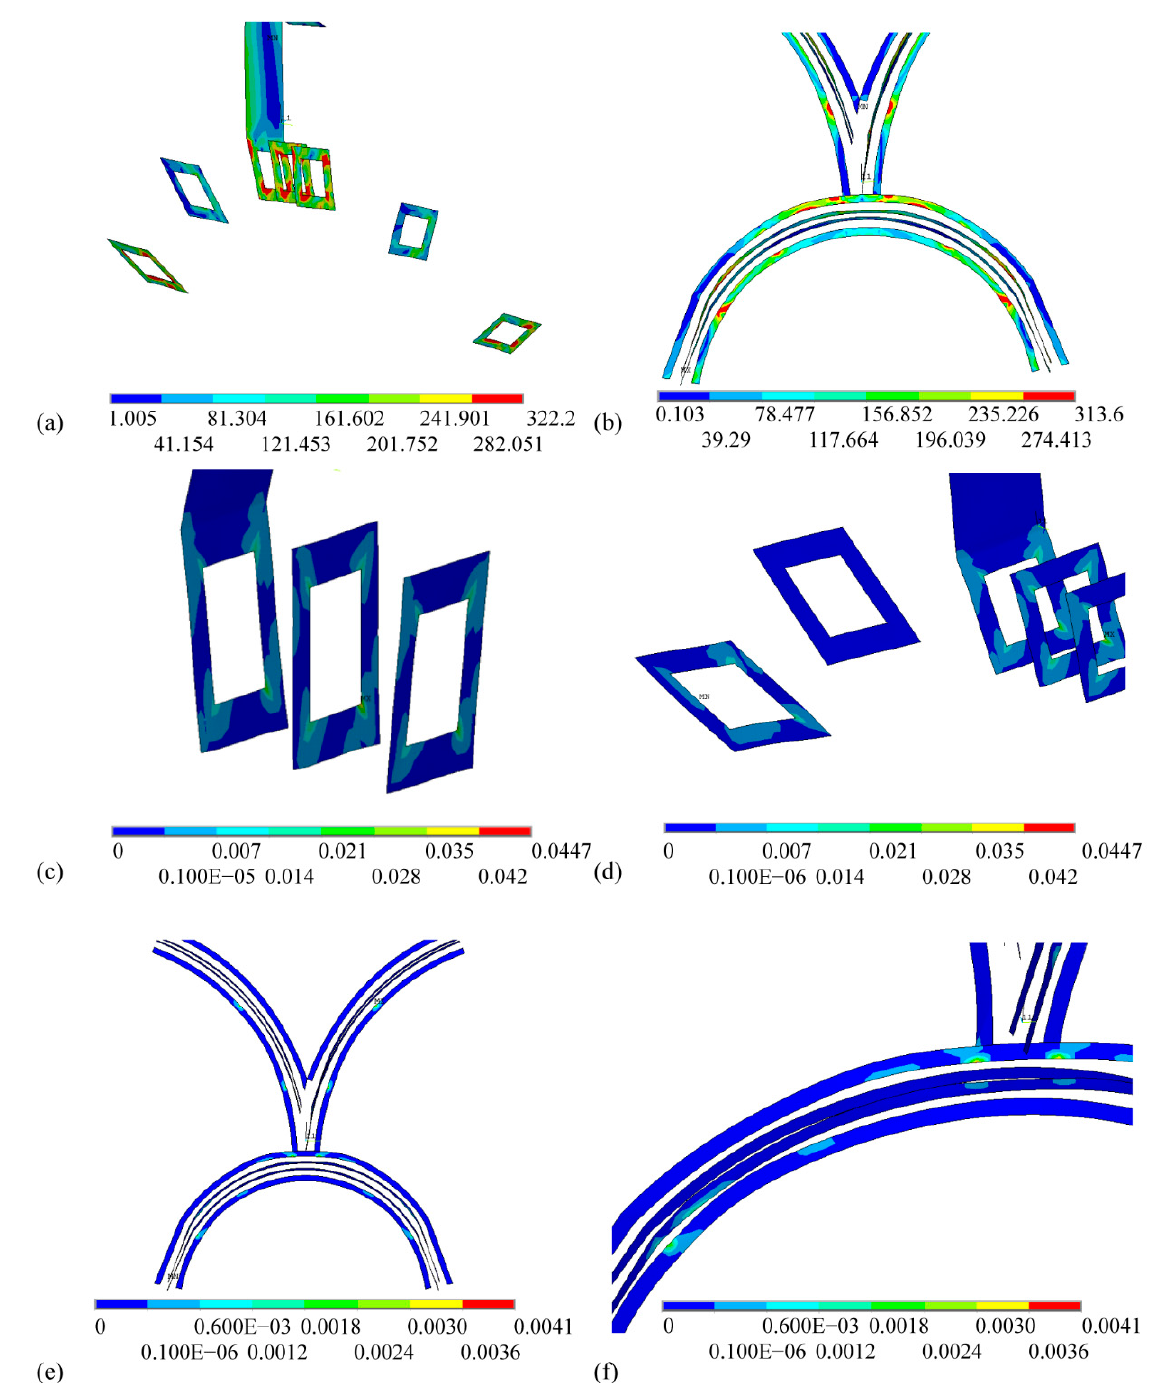
Figure 6. Mises stress in the ( a ) diaphragm and ( b ) longitudinal stiffening rib and the plastic strain in the ( c ) diaphragm in the juncture node zone, ( d ) lower diaphragm, ( e ) longitudinal stiffening rib, and ( f ) magnified perspective of the longitudinal stiffening rib for the initial model.